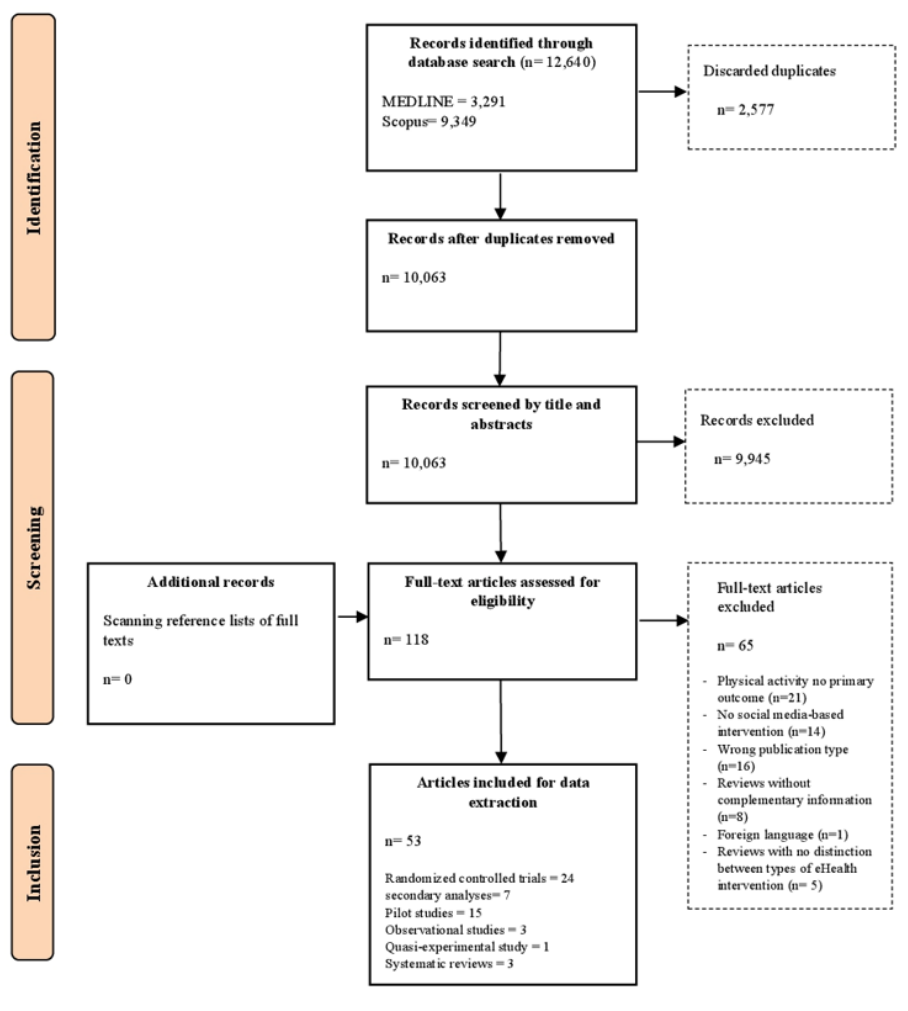
Figure 1. Flow chart of the selection process.